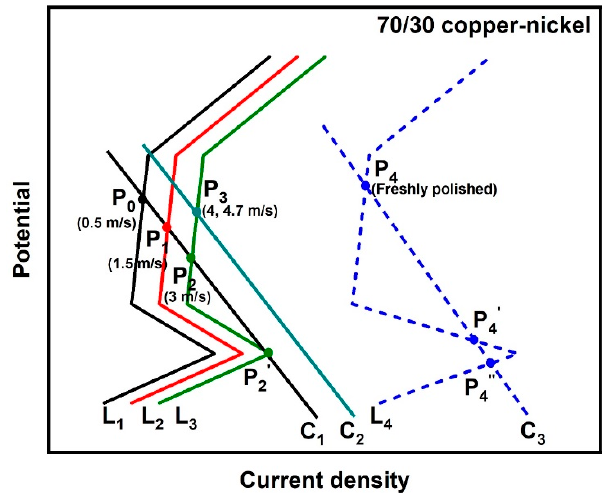
Figure 11. An ideal schematic mechanism of the corrosion process of the 70/30 copper–nickel tube in NaCl solution at different flow velocities.